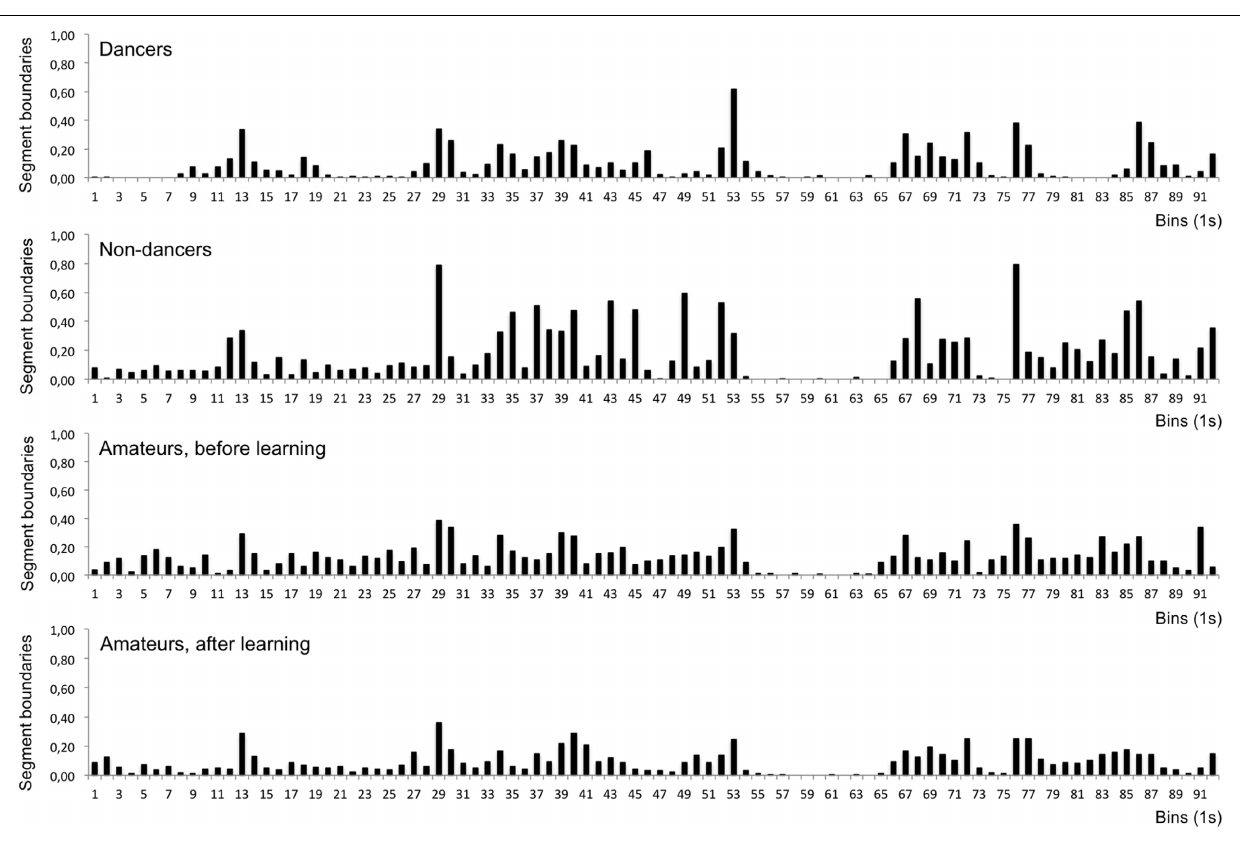
FIGURE 4 | Results of Experiments 1 and 2. Distribution of segment boundaries over the phrase: average number of segment boundaries for each bin (1s), calculated over all trials; panels from top to bottom: dancers, non-dancers, amateurs before learning the phrase, amateurs after learning the phrase. The most frequently set segmentation boundaries marked the